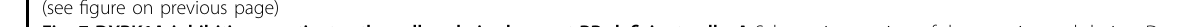
cell proliferation. Bar graphs represent mean ± SEM from at least three independent experiments (two-tailed unpaired t -test; * P < 0.05, ** P < 0.01, *** P < 0.001, **** P <